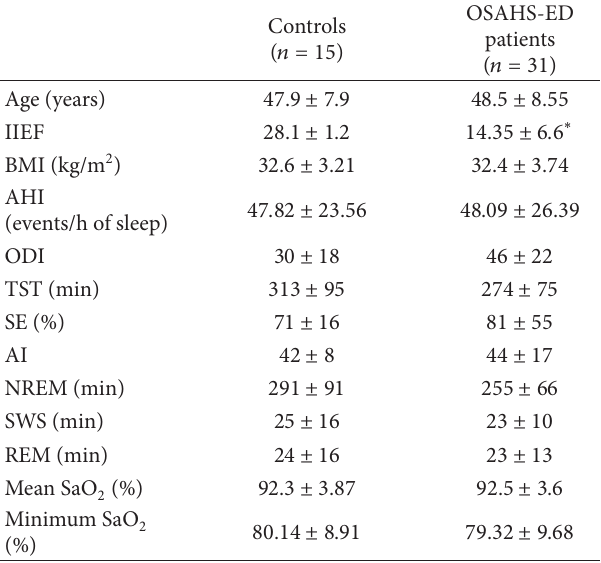
Table 1: Baseline clinical and PSG characteristics of controls and OSAHS patients with ED